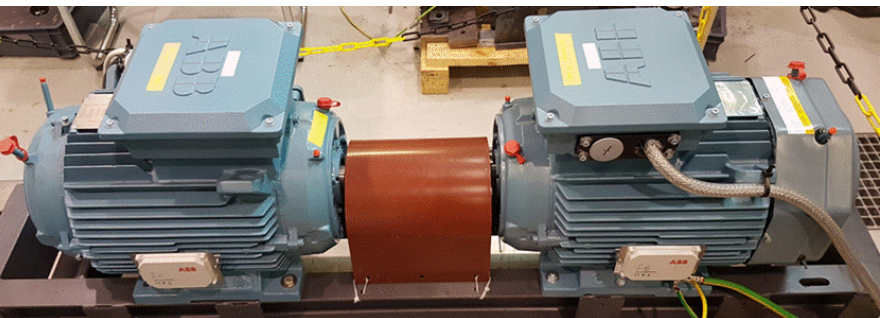
Figure 5. The motor ( left ) and the generator ( right ) at a test bench set-up at LUT. The rotor bar testing was carried out with a healthy and a faulty rotor bar over a predefined test program covering rotation speeds of 900 RPM, 1200 RPM, and 1500